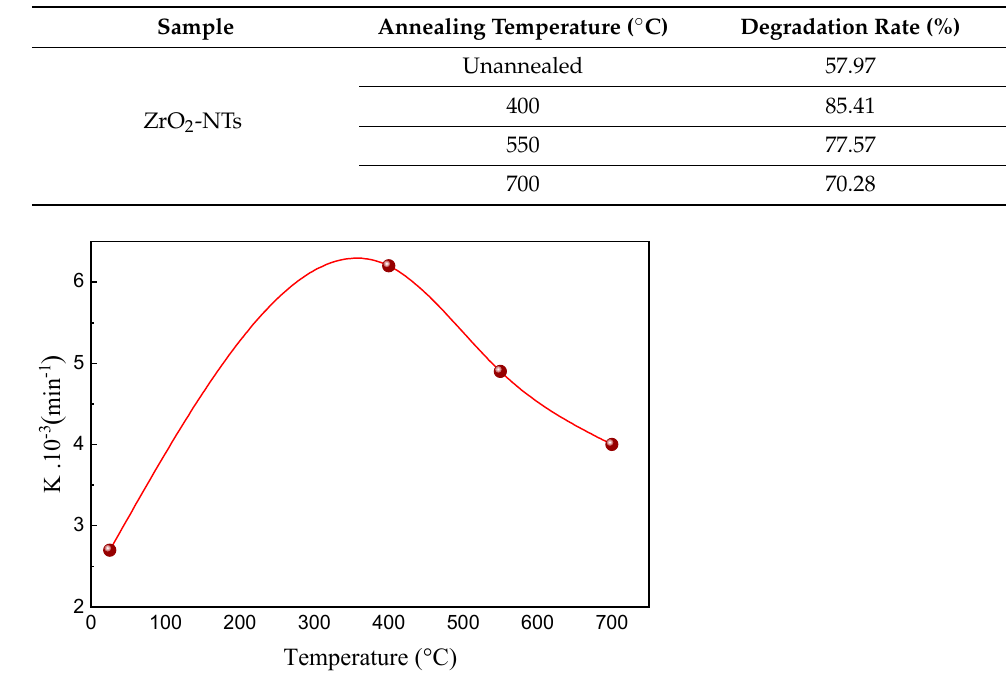
Figure 11. Kinetic study of ln ( A 0 / A ) versus irradiation time in the presence of ZrO 2 NTs. Perceptibly, the ZrO 2 NTs that were annealed at 400 ◦ C show the highest photocatalytic performance, with the highest decolorization rate constant of K = 6.2 10 − 3 min − 1 . Figure 11 shows that the samples annealed at 400 ◦ C present the best photocatalytic